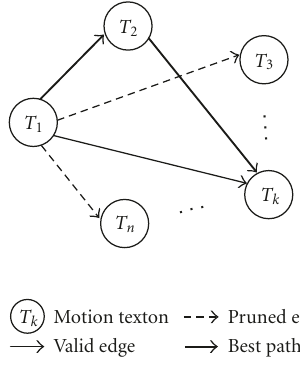
Figure 7: Motion graph